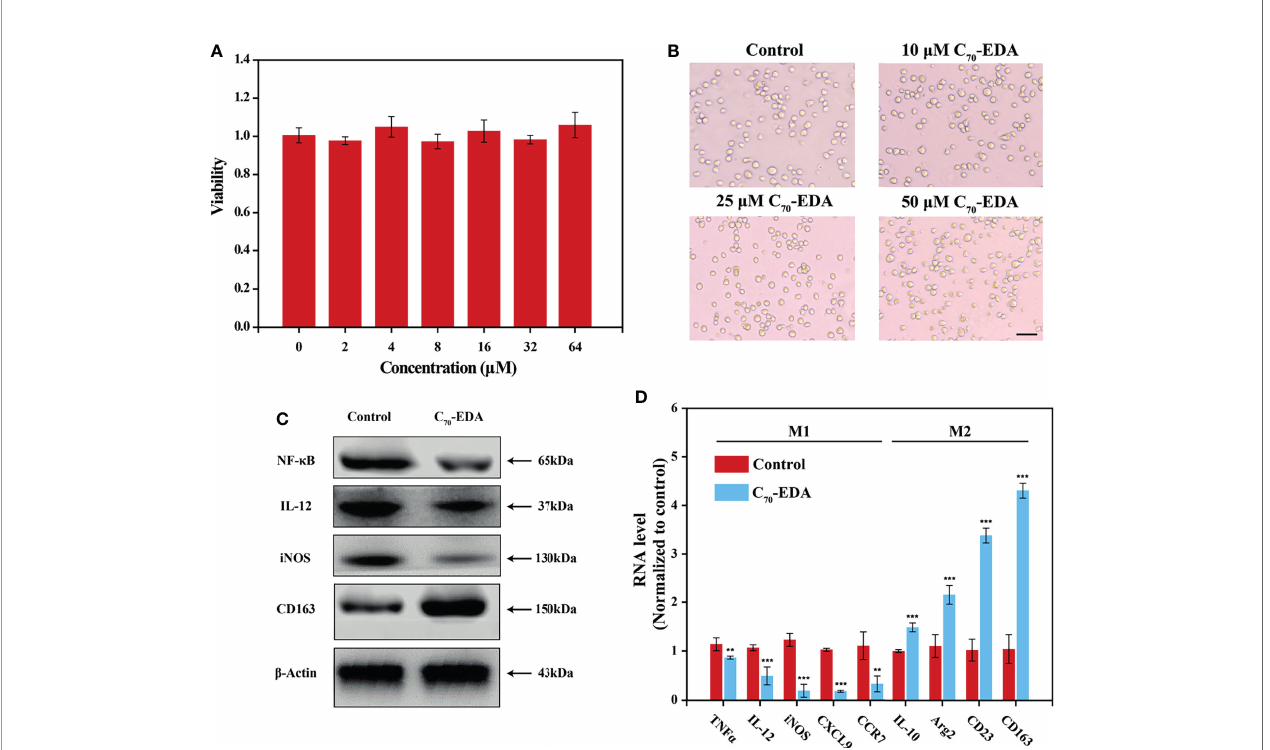
FIGURE 1 | C 70 -EDA induced THP-1 cells to an M2-like state. (A) Viability and (B) morphology of THP-1 cells treated with different concentrations of C 70 -EDA for 24 h (n = 4). The scale bar is 20 m m. (C, D) THP-1 cells were treated with PBS (control) or 50 m M C 70 -EDA for 24 h. (C) The protein levels of M1 markers (NF- k B, IL-12, and iNOS) and M2 markers (CD163) in THP-1 cells as determined by Western blotting. (D) The mRNA levels of M1 markers (TNF a , IL-12, iNOS, CXCL9, and CCR7) and M2 markers (IL-10, Arg2, CD23, and CD163) by RT – PCR (n = 4). The data are reported as the means ± s.d., and n represents the number of biologically independent samples. Statistical signi fi cance was calculated by Student ’ s t-test. **p < 0.01 and ***p <